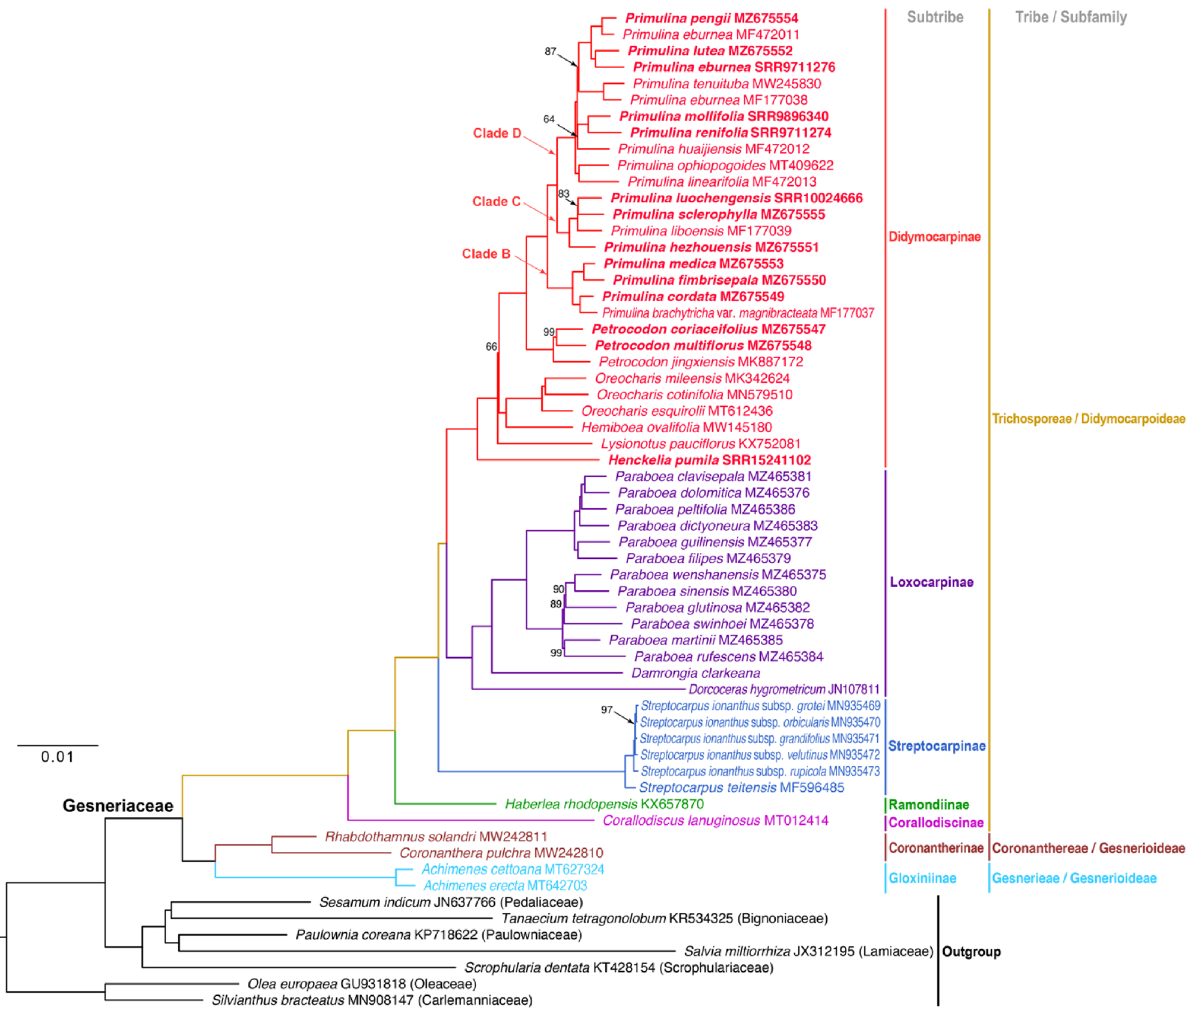
Figure 7. The ML phylogram of 54 Gesneriaceae plastomes and seven Lamiales outgroups reconstructed by IQ-TREE. Nodes with full ultrafast bootstrap support values were not labeled with any number, while those values which are not equal to 100 were labeled out. Each clade within Gesneriaceae was colored by subtribes following the classification in Weber et al. 1 . The three major clades of Primulina were labeled corresponding to the Clades B, C, and D in Kong et al. 16 . Species name in bold indicates that the plastome is generated or assembled in this